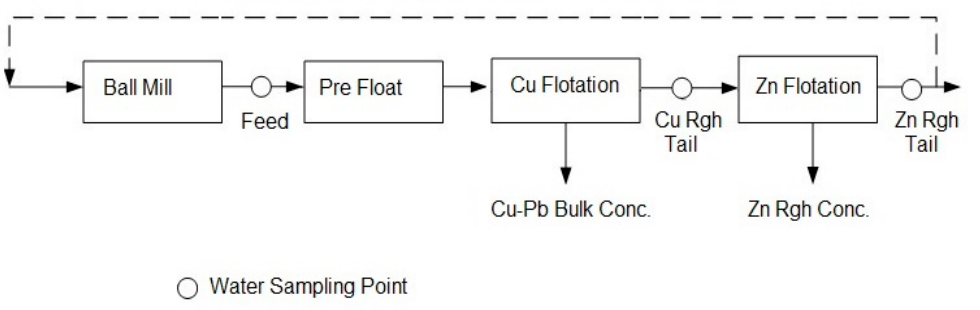
Figure 1. Flotation test flowsheet and water sampling points.